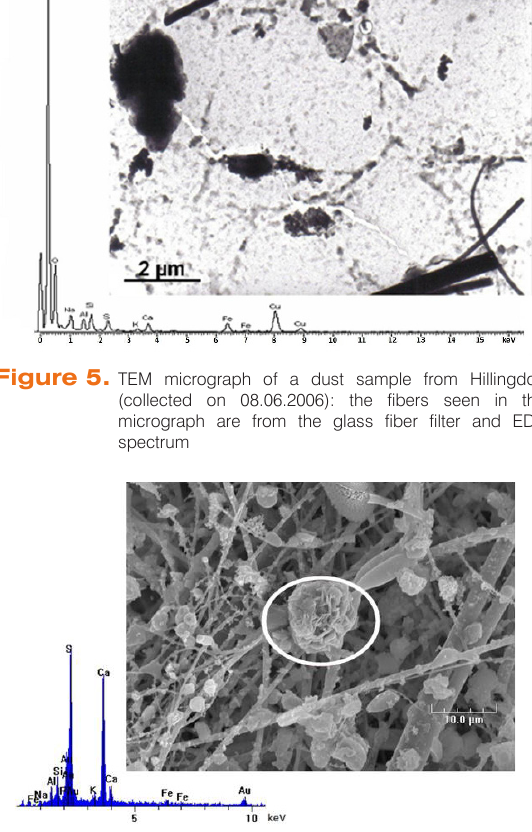
Figure 6. Dust samples from Gdansk (collected on 16.06.2006) and EDX spectrum